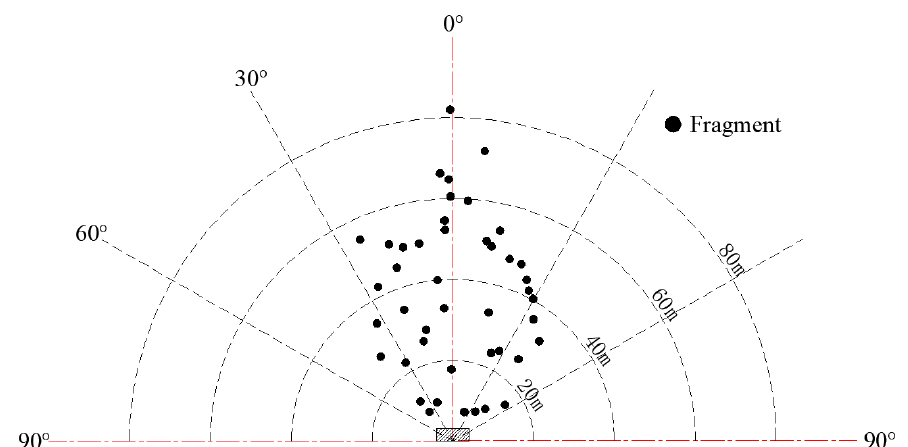
Figure 10. Distribution of structural fragments.